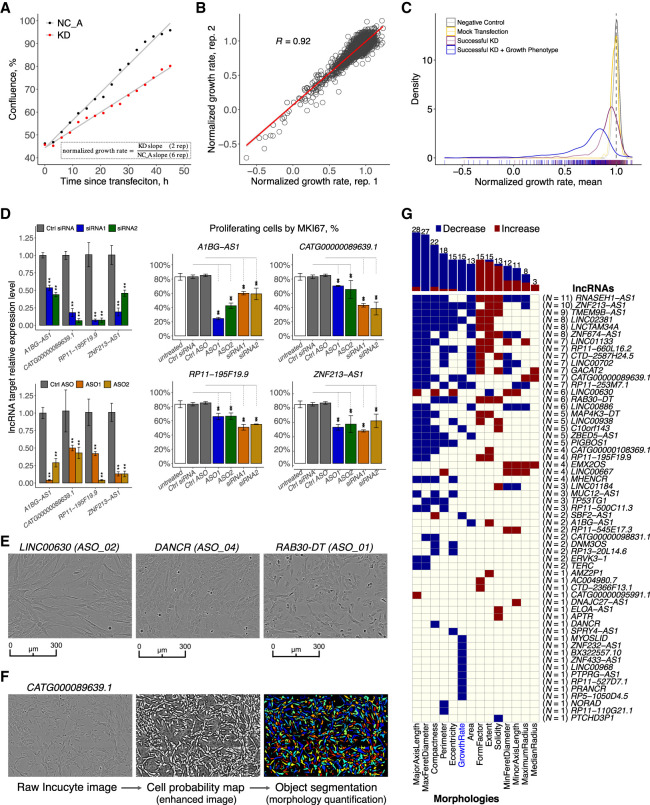
Cell growth and morphology assessment. (A) Selected example (PTPRG1-AS1) showing the normalized growth rate estimation using a matching NC_A (negative control). (B) Correlation of the normalized growth rate for technical duplicates across 2456 Incucyte samples. (C) Density distribution of normalized growth rates (technical replicates averaged) 252 ASOs targeting lncRNAs with successful knockdown (KD) and growth phenotype (blue) consistent in two replicates (FDR < 0.05 as compared to matching NC_A; 246 ASOs inhibited growth), 627 ASOs targeting lncRNAs with successful KD (purple), 270 negative control (NC_A) samples (gray), and 90 mock-transfected cells (Lipofectamine only) samples (yellow). (D) MKI67 staining (growth inhibition validation) for four selected lncRNA targets after siRNA and ASOs suppression. (E) Incucyte cell images of selected distinct cell morphologies changes upon an lncRNA KD. (F) An overview of the cell morphology imaging processing pipeline using a novel lncRNA target, CATG000089639.1, as an example. (G) lncRNAs (N = 59) significantly (FDR < 0.05) and consistently (after adjusting for the number of successfully targeting ASOs) affecting cell growth (N = 15) and cell morphologies (N = 44).